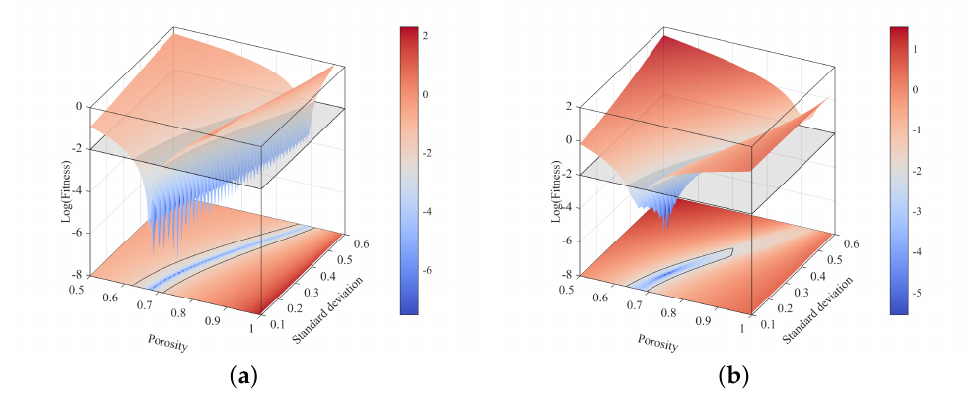
Figure 10. 3D profile of the logarithm of fitness function versus the porosity φ and standard devi- ation σ s with the fixed fibre diameter d , and 2D projection along φ − σ s plane with contour plot at Log ( Fitness ) = − 2, ( a ) d t = 15.07, inversion from Z s , ( b ) d t = 15.07, inversion from ( Z c , k c ) .